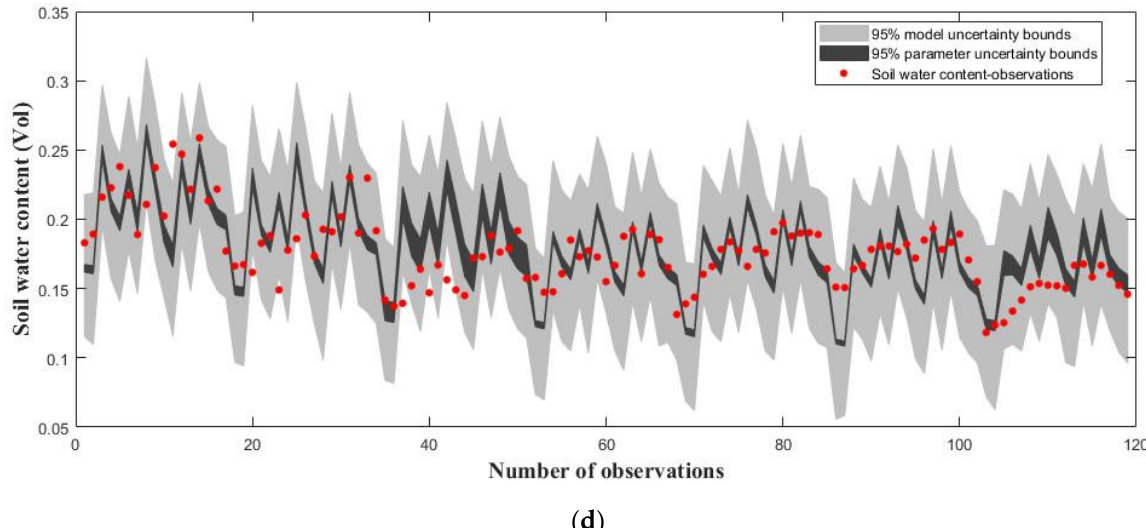
Figure 4. Plots of simulated and reference soil water content. 95% simulation uncertainty intervals due to parameter (dark region) and total uncertainty (light gray). The measured soil water content values are indicated with red points. ( a ) ILUES-calibration; ( b ) ESMDA-calibration; ( c ) ILUES-validation; ( d ) ESMDA-validation.